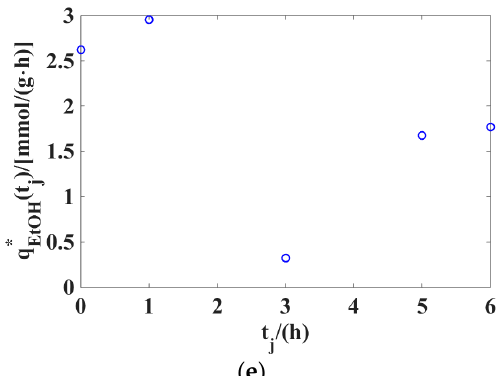
Figure 1. The optimal values µ * ( t j ), q ∗ s ( t j ), q ∗ PD ( t j ), q HAc ( t j ), and q EtOH ( t j ), obtained by solving the optimization problem in Equations (79)–(90) in the first stage of the two-stage method: ( a ) µ * ( t j ); ( b ) q ∗